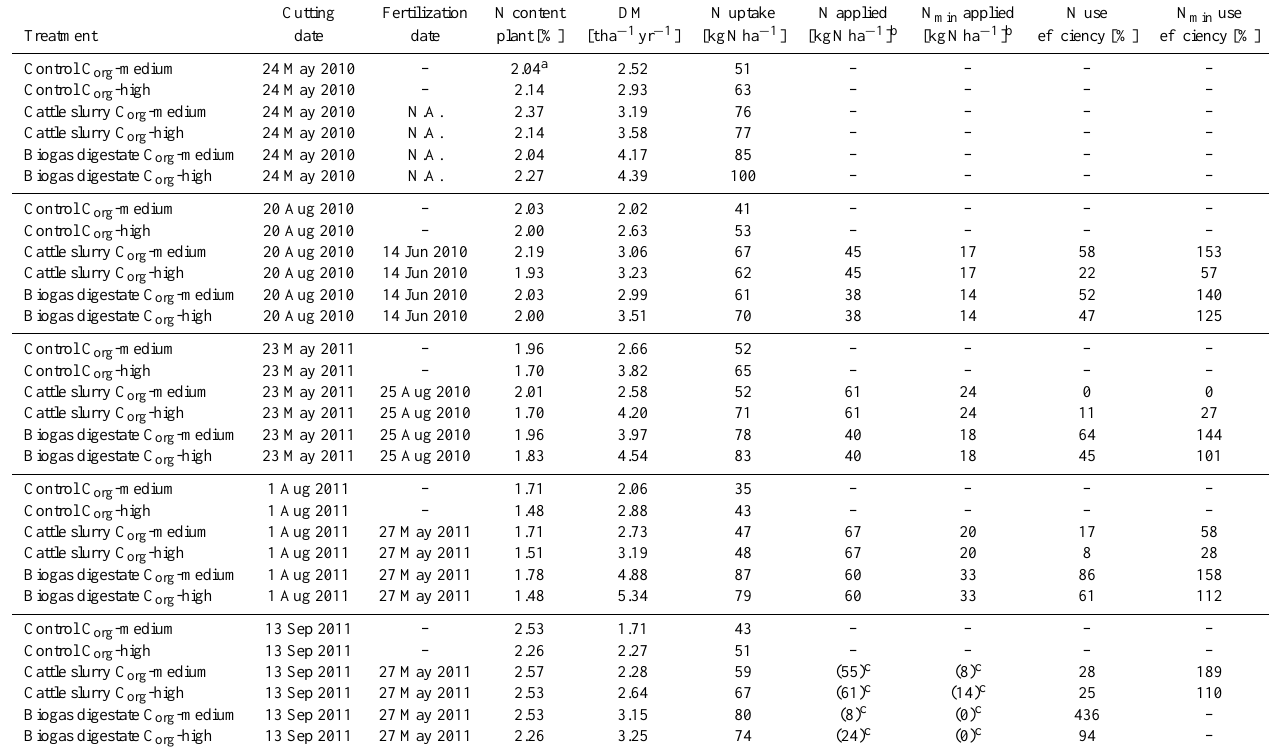
Table 6. Grass yields, N uptake and N use efficiency for the years 2010 and 2011.